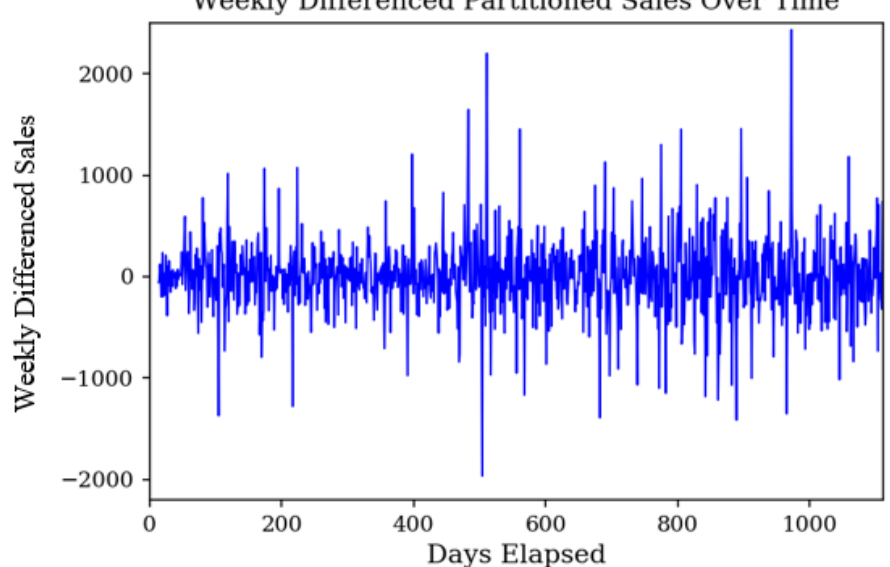
Figure 6. Weekly Differenced Sales. We plot the weekly differenced sales generated using Equation (2) for each instance in the dataset.